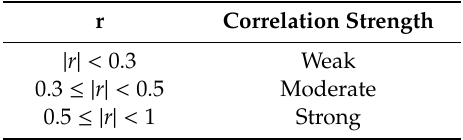
Table 1. The three-level correlation strength guideline.